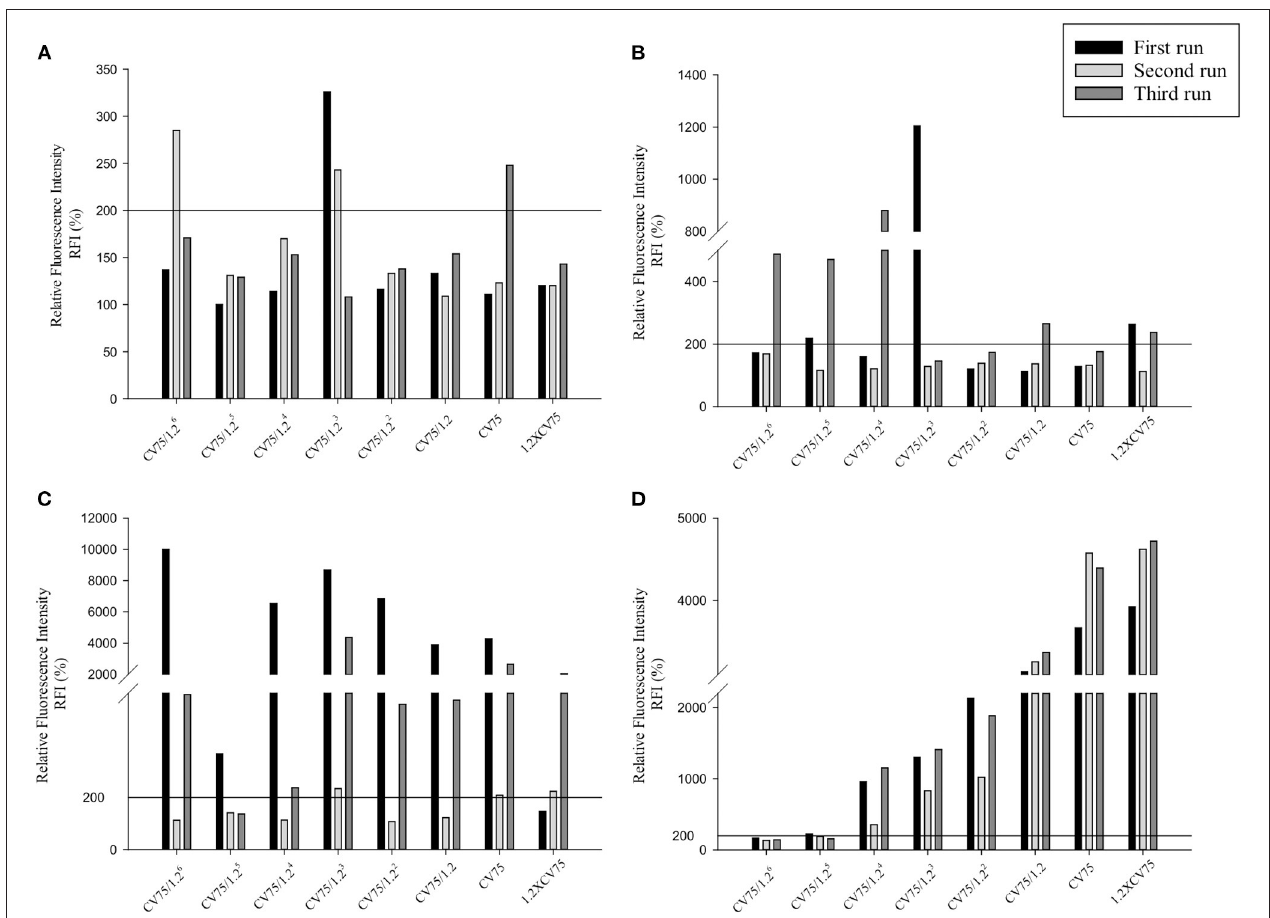
FIGURE 2 | Relative Fluorescence Intensity (RFI) data of three different runs for CD54 of (A) 20nm AgNPs (B) 50nm AgNPs (C) 80nm AgNps and (D) ZnO NPs at different concentrations (1/1.2 6 × CV75, 1/1.2 5 × CV75, 1/1.2 4 × CV75, 1/1.2 3 × CV75, 1/1.2 2 × CV75, 1/1.2 × CV75, CV75, 1.2 × CV75). RFI were obtained by calculating the percentage of CD54 MFI of NPs treated cells compared to CD54 MFI of solvent/vehicle treated cells after reduction of CD54 MFI of isotypes of respective